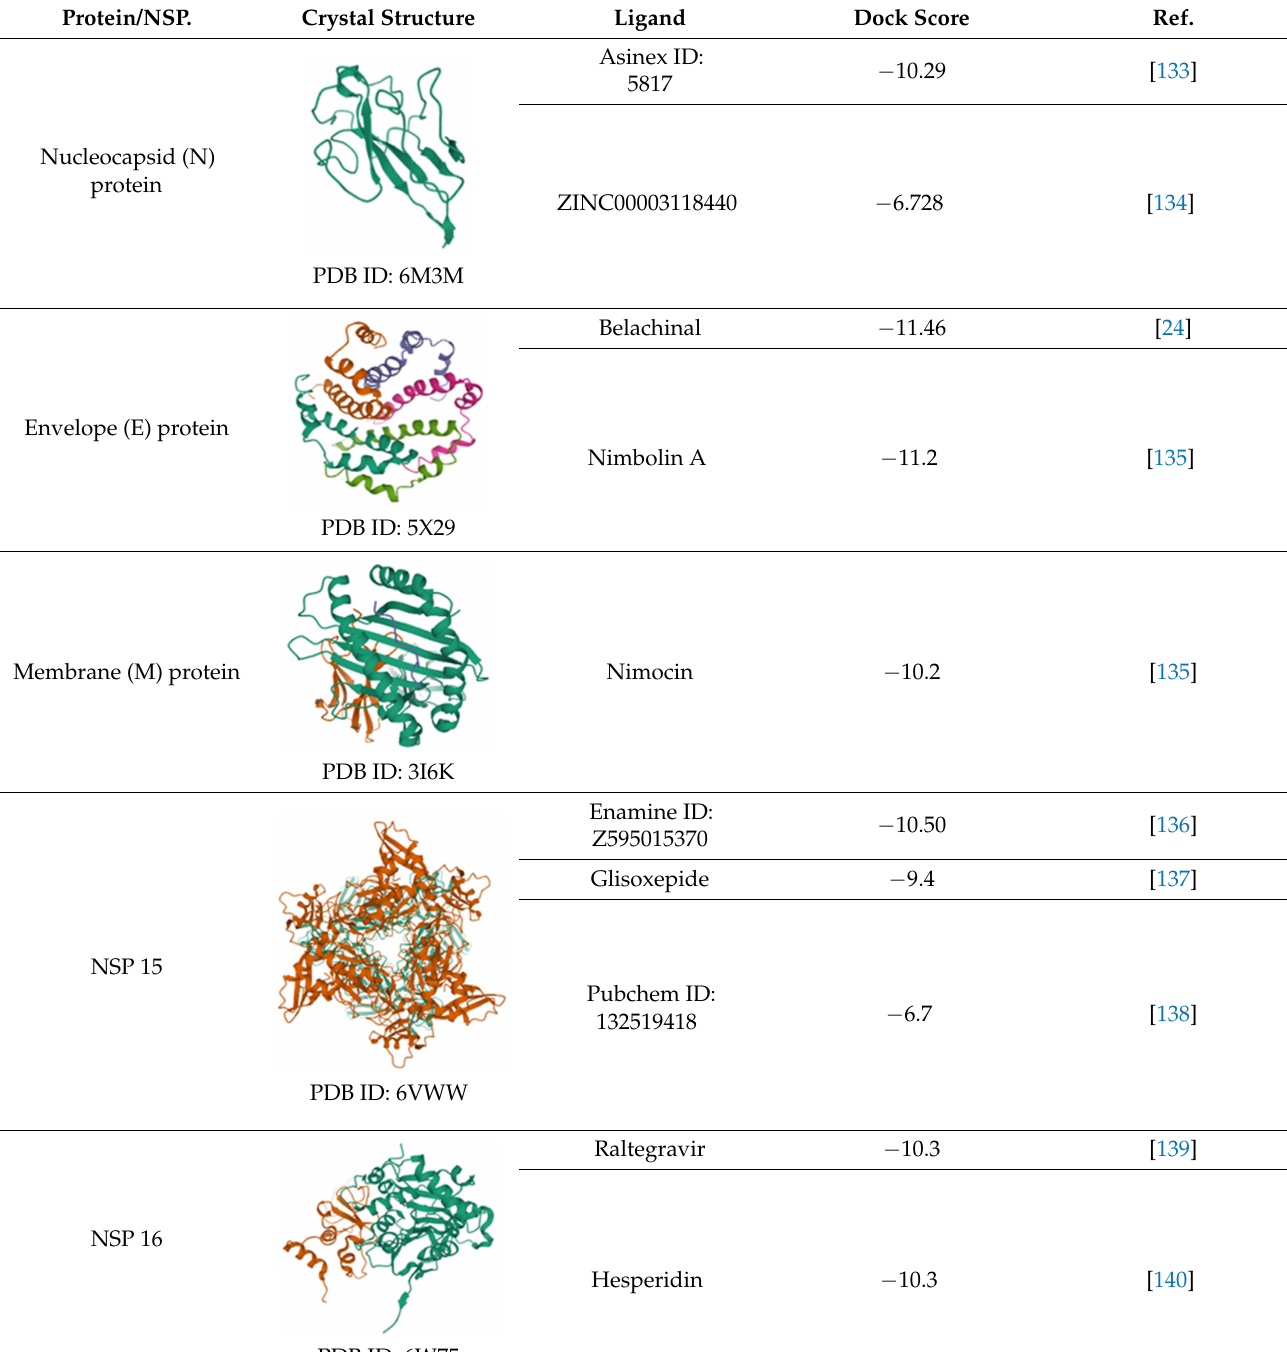
Table 4. Nonstructural proteins of SARS-CoV-2. Summary of nine computational studies.